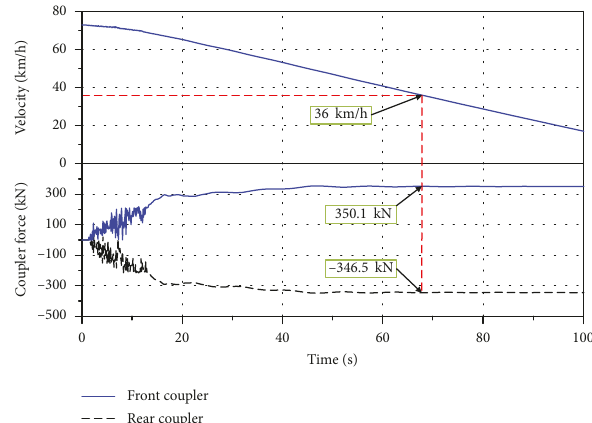
Figure 12: The velocity and coupler forces of the second 3-pack during dynamic